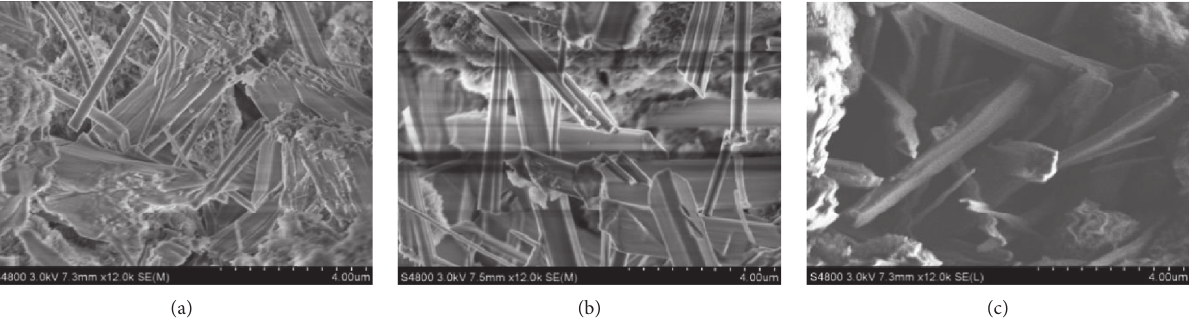
Figure 7: SEM image of LASC cured foam filling material when molded for seven days. (a) FGS 1. (b) FGS 2. (c) FGS